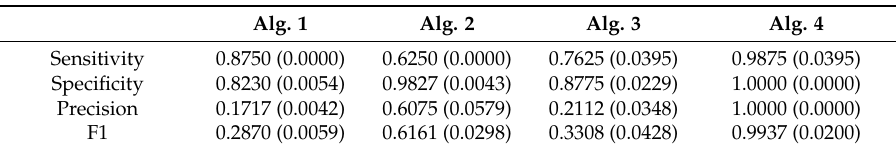
Table 7. A 10-fold cross-validation of the presented algorithms using the DLR dataset. The table shows the average values and the standard deviations in parentheses.